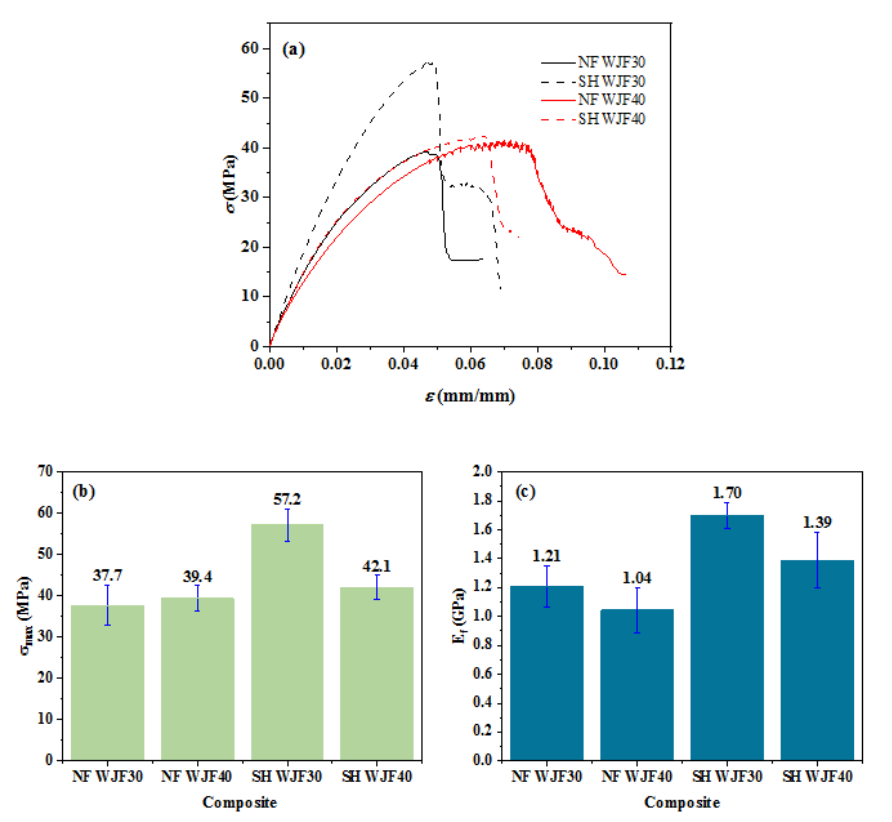
Figure 8. Results of the three-point bending analysis: ( a ) Representative curves σ vs. ε of the bio-composites, ( b ) σ max values for the composites, ( c ) E f values for the composites.